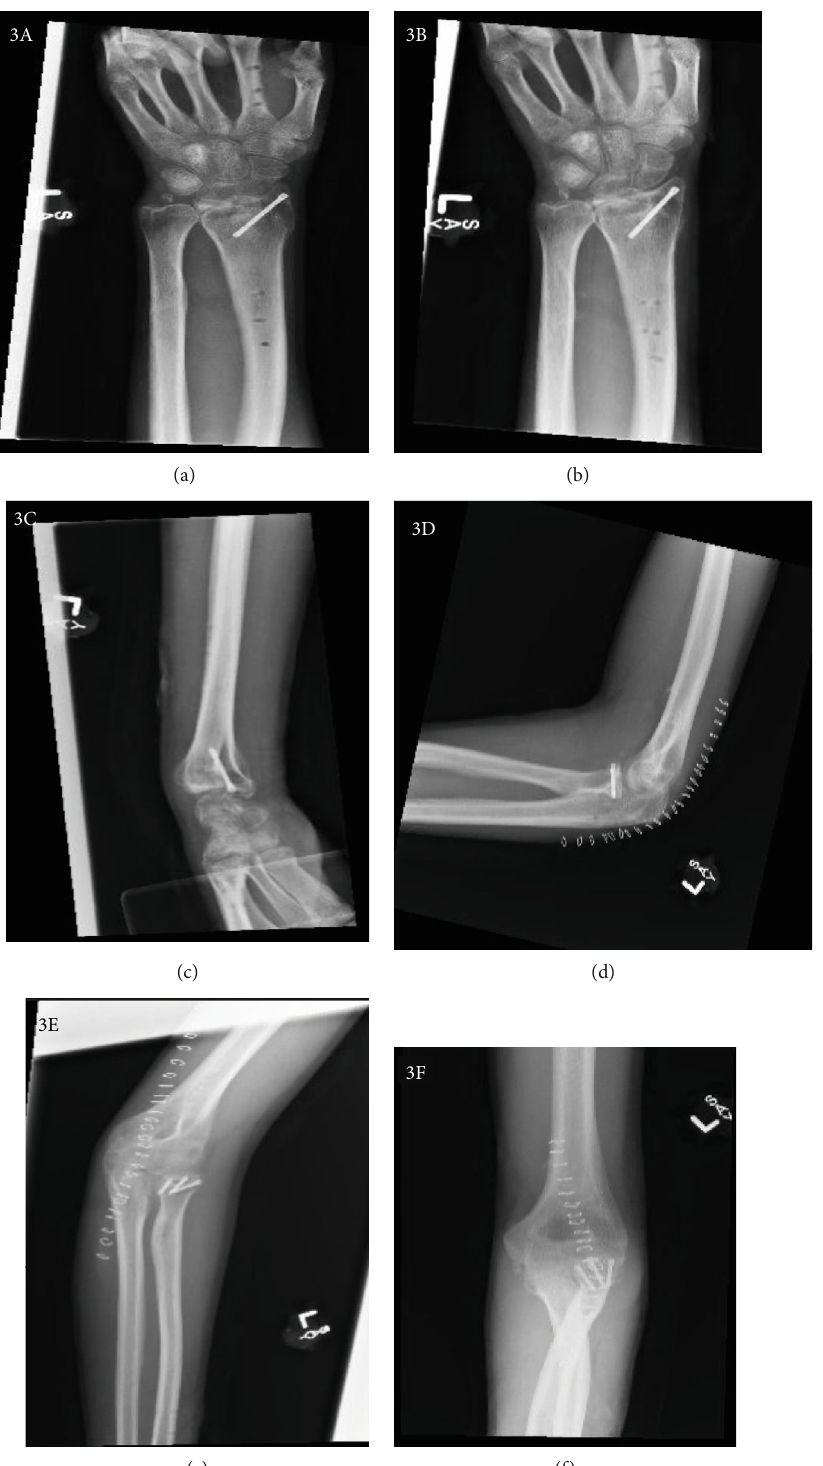
Figure 3: Radiographs at fi nal follow-up showing healed fractures. Left wrist PA (a), external rotation (a) and lateral rotation (c). Left elbow lateral (d) and AP 2 views (e,